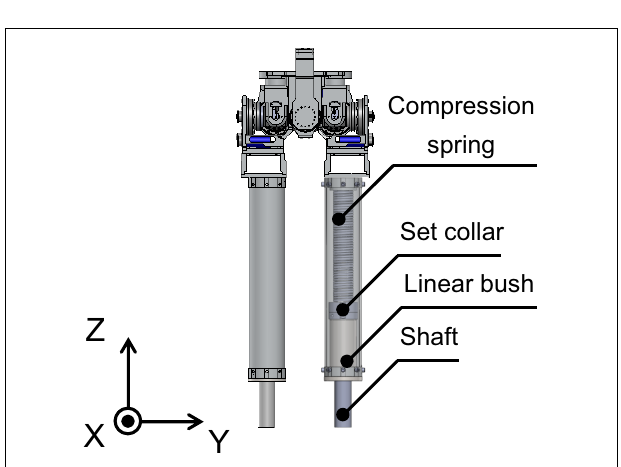
FIGURE 8 | Computer aided design of developed running robot . To adjust the mass, weights can be mounted on the upper part of the robot. A compression spring, shaft, set collar, and linear bush served as the spring of the leg. Owing to this mechanism, the compression spring is not detached from its upper and lower parts when the spring is at free length.